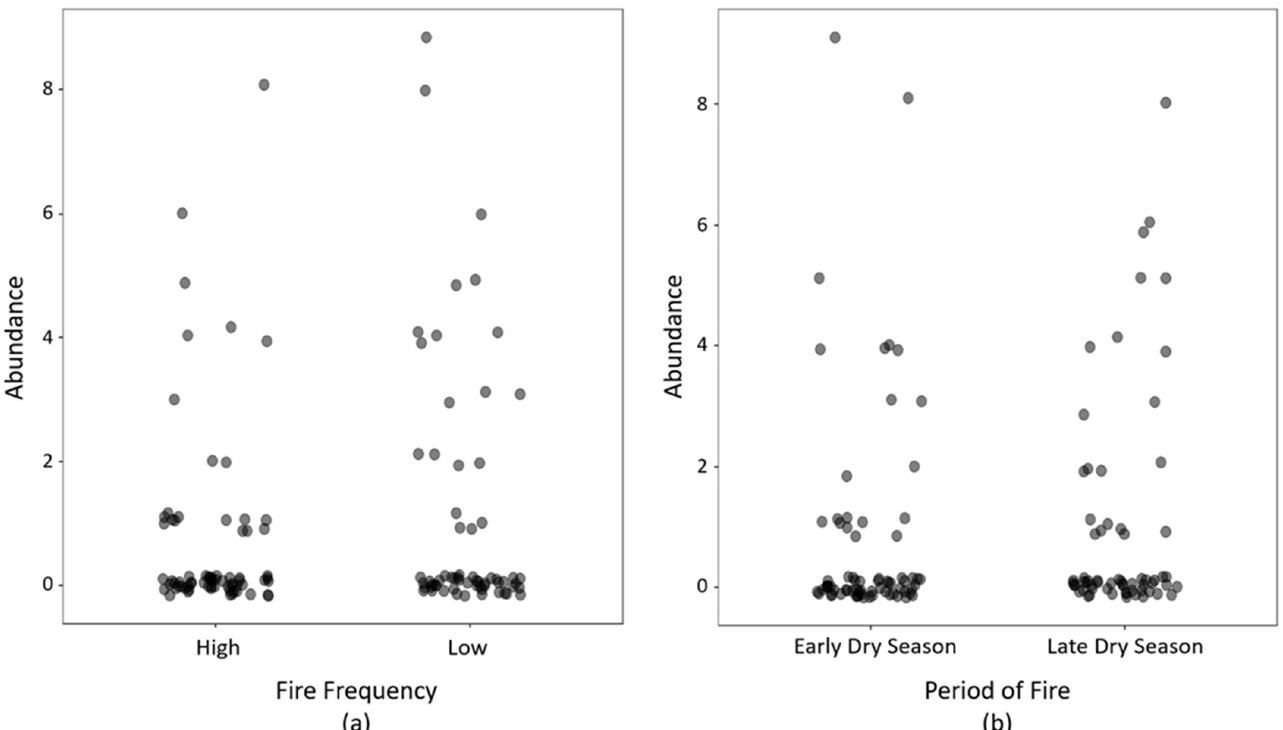
Figure 4. ( a ) The number of sun spiders collected by pitfall traps at sites with different fire frequency ( a ) and early vs late in the season ( b ) in the Kadiwéu Indigenous Reserve, Porto Murtinho, Mato Grosso do Sul State, Brazil. High fire frequency means more than seven fire events in 2001–2020, while low fire frequency is seven or less. A fire is considered an early dry season event if it occurred between January and June in 2020, and late in July or after.